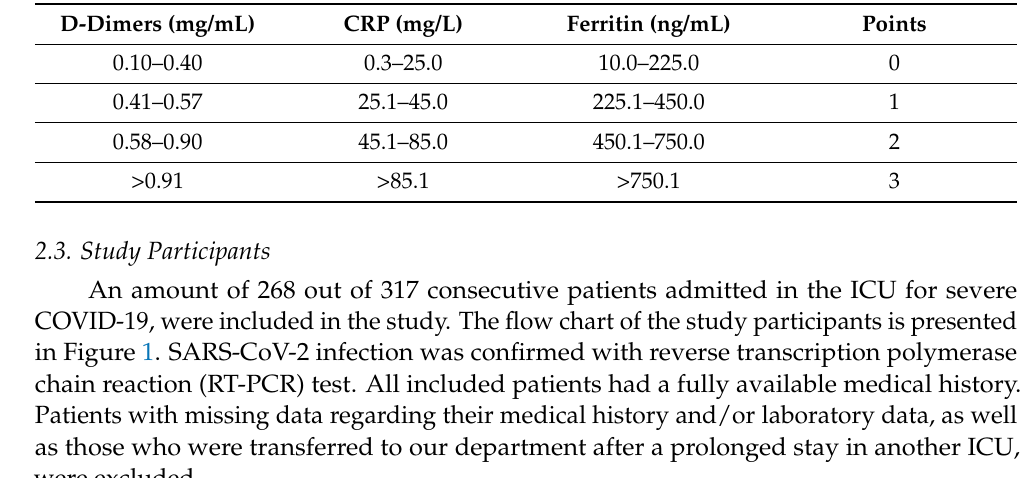
Figure 1. Flow chart of the study participants.